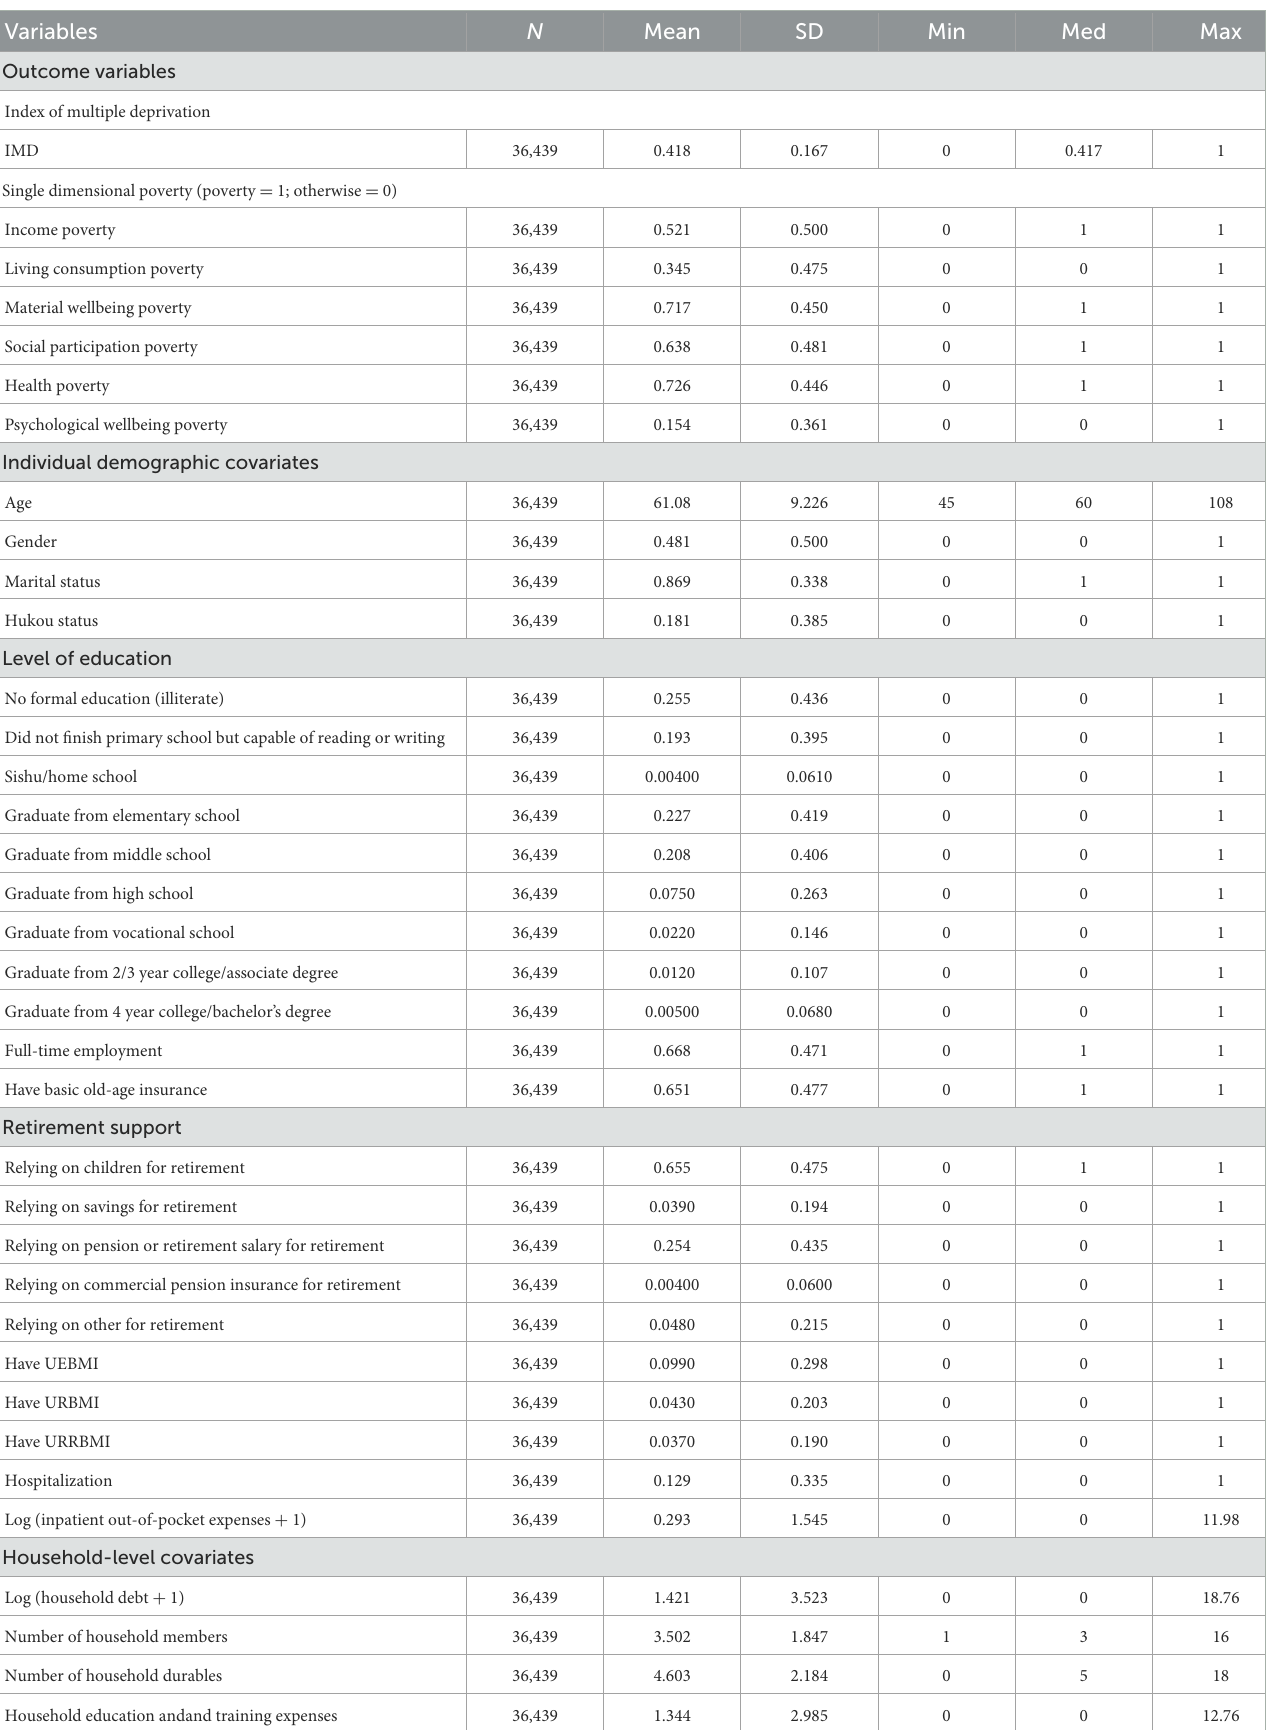
TABLE 2B Descriptive statistics (full